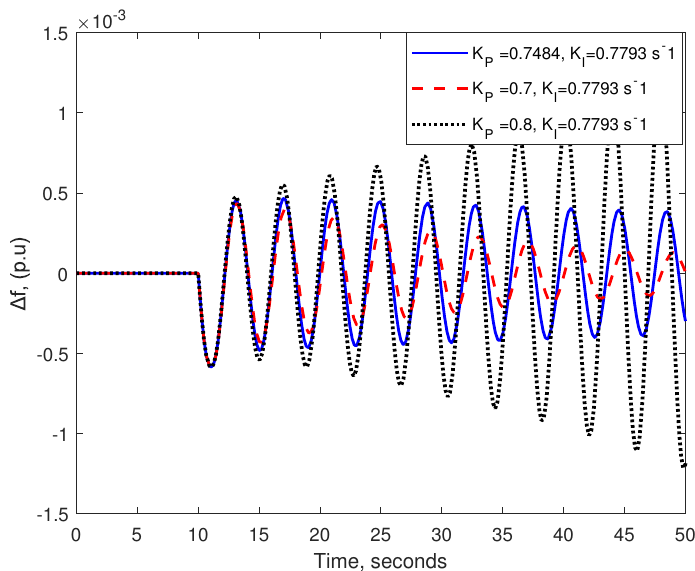
Figure 8. The frequency deviation with different K P ’s and K I